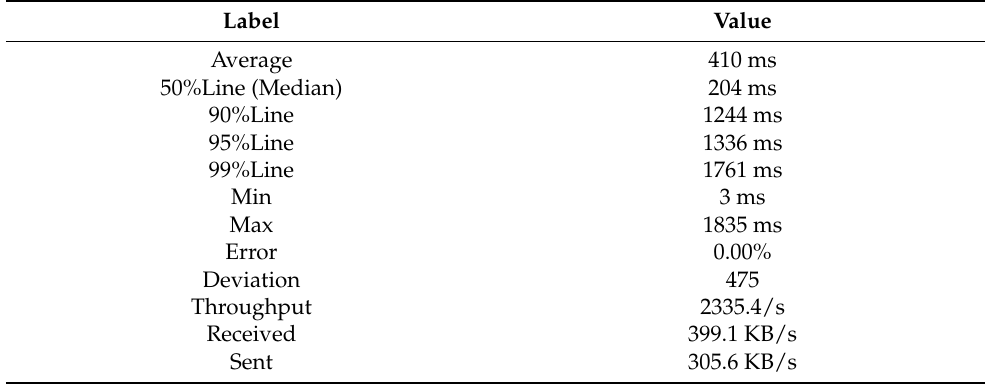
Table 2. Performance indicators of the system